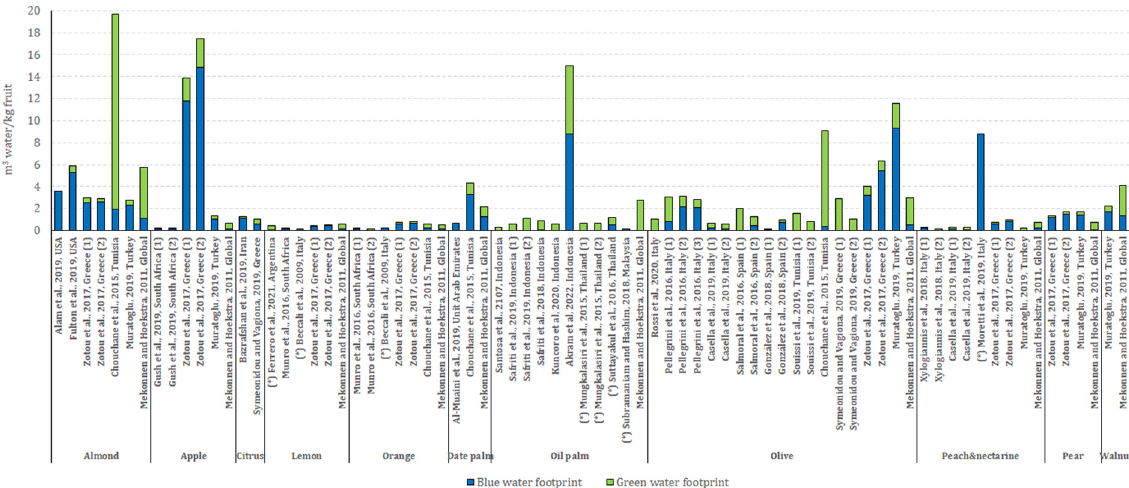
Figure 10. WF results obtained in case studies and mixed approaches for orchard trees at the accounting or inventory phase. Notes: (*) refers to results following the LCA-based approach; numbers (1–3) refer to different occurrences within a study due to different scenarios studied. Table 2. WF results obtained for forest trees at the accounting or inventory phase for case studies and mixed approaches that reported water volume per m 3 of wood produced.